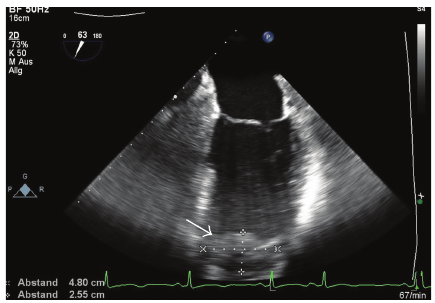
Figure 5: Transesophageal echocardiographic assessment of the left ventricular thrombus in the two-chamber view. The thrombus is marked with a white arrow.